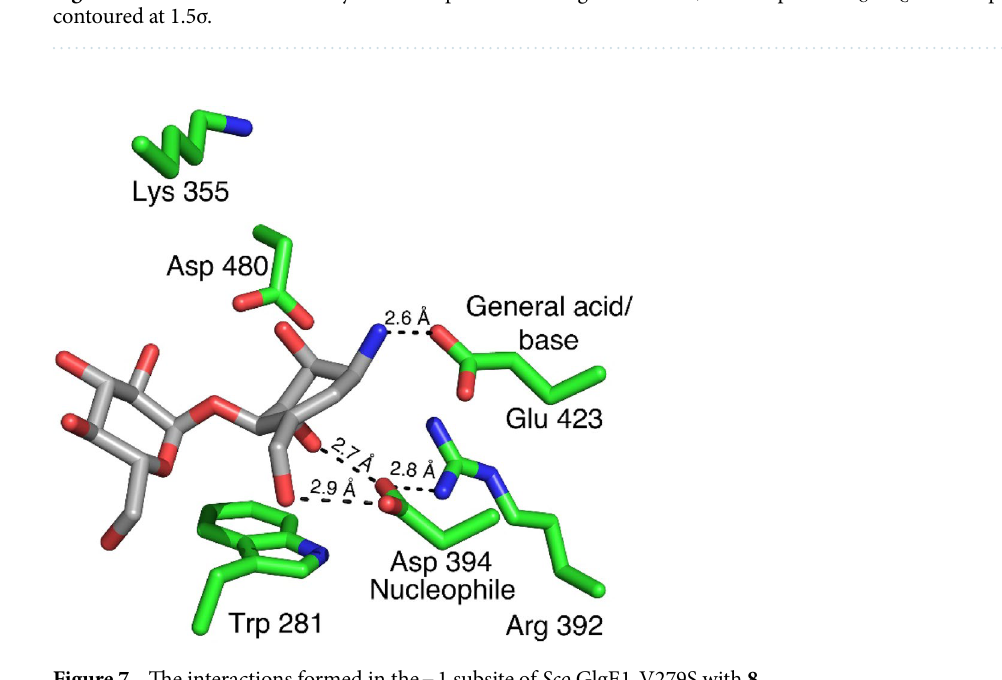
Figure 7. The interactions formed in the − 1 subsite of Sco GlgE1-V279S with 8